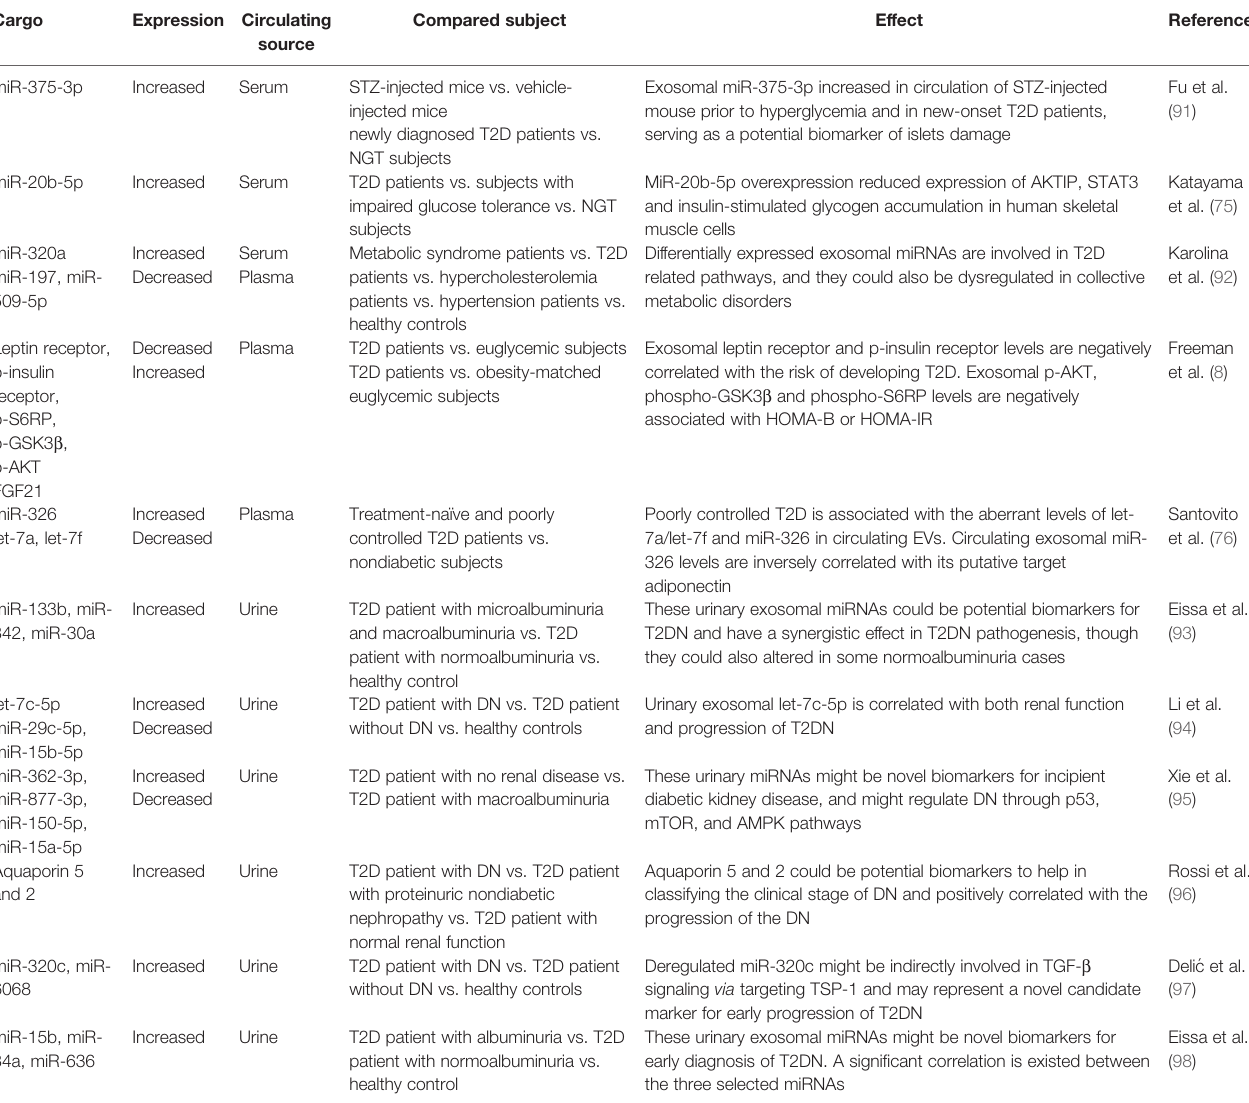
TABLE 1 | Molecules in cirulating EVs as biomarkers of